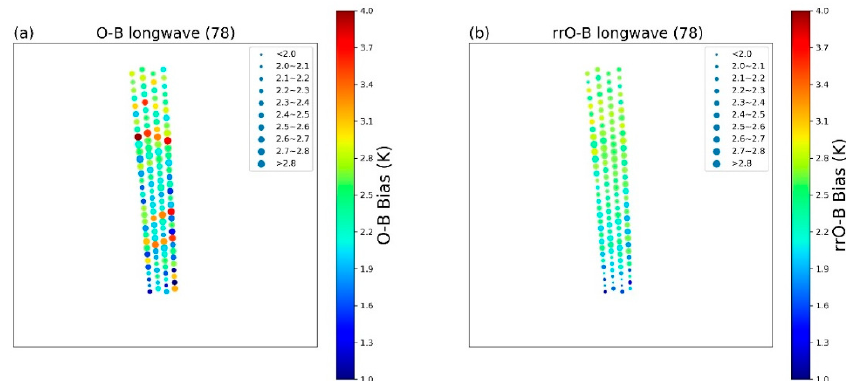
Figure 9. ( a ) Half-month average array distribution characteristics of the background departures (O-B) of channel 78; and ( b ) half-month average array distribution of the reconstructed background departures (rrO-B) of channel 78. The size of the dot represents the standard deviation of the O-B or rrO-B, and the color represents O-B or rrO-B bias.